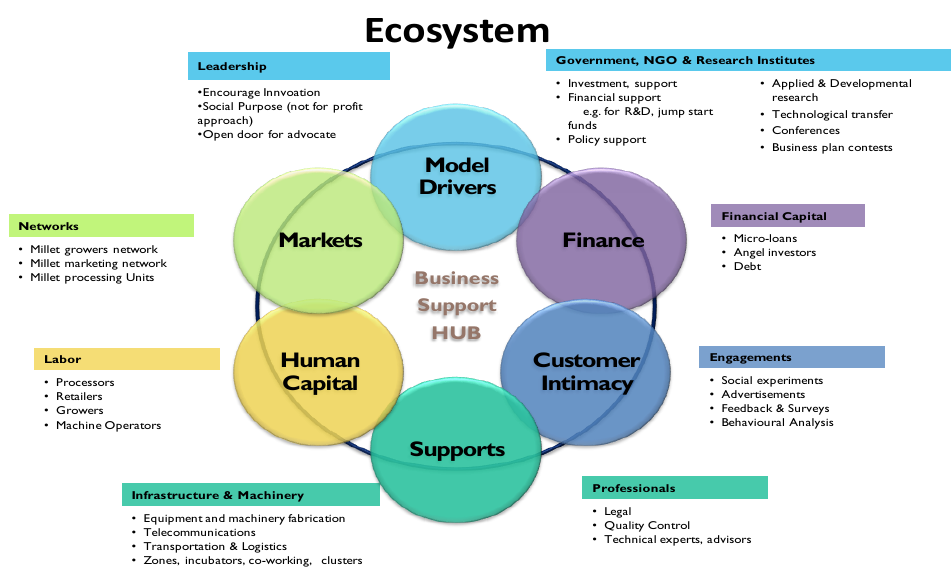
Figure 6. Ecosystem for a proposed open innovation concept for the Indian small millets agribusiness chain.